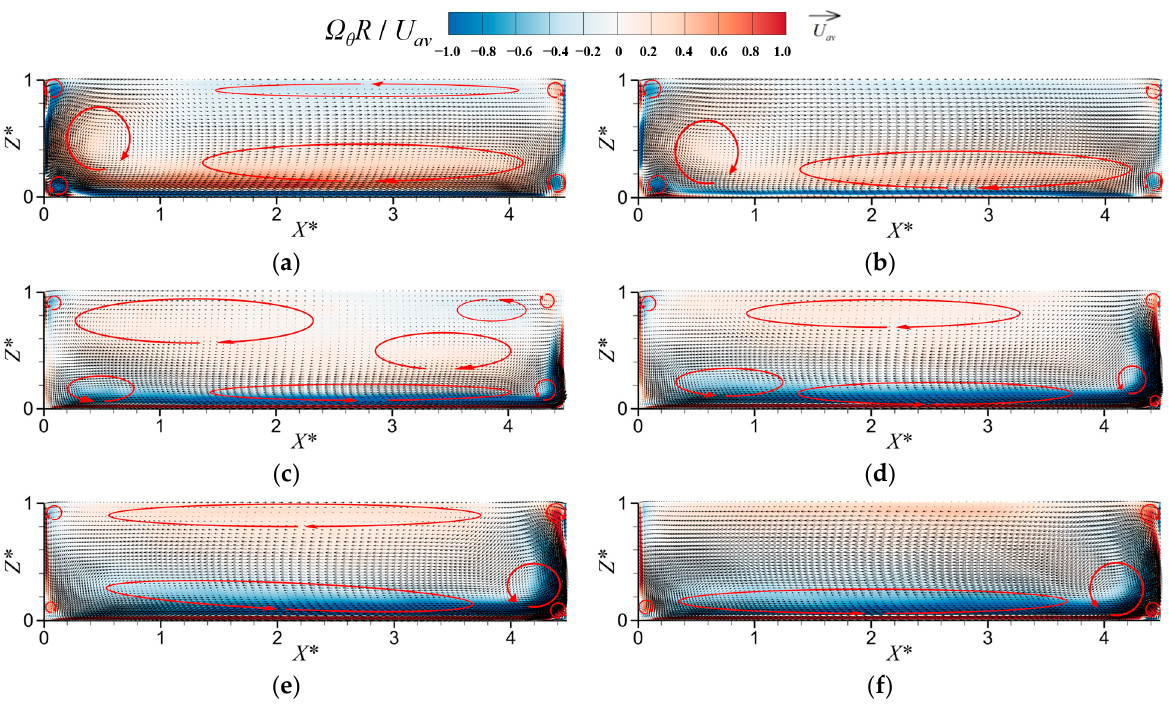
Figure 9. Normalized vectors of secondary currents velocities with a background of contours showing dimensionless streamwise vorticity. (From left to right denotes from inner bank to outer bank). ( a ) Section #01; ( b ) Section #02; ( c ) Section #03; ( d ) Section #04; ( e ) Section #05; ( f ) and Section #06.